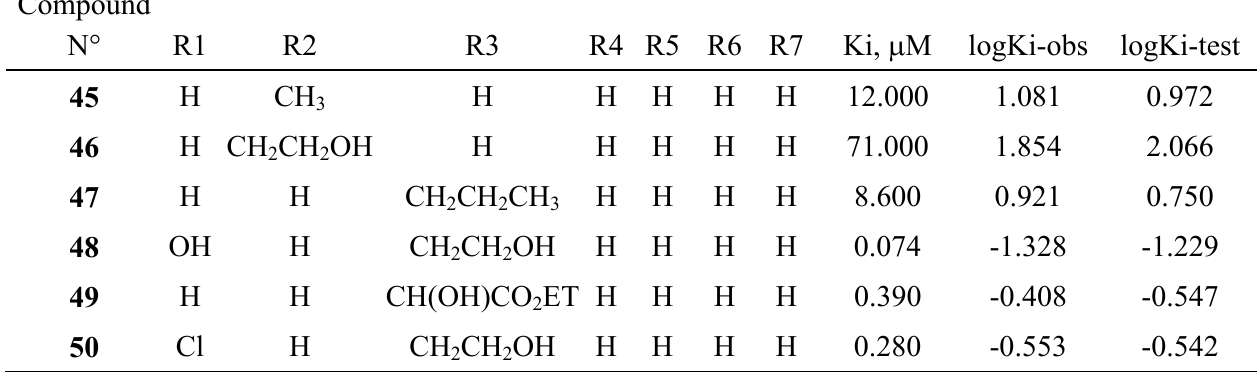
Table 5. The chemical structure of the 6 tested compounds (test set). Values of observed logKi (logKi- obs) corresponding to reference [4] and values of predicted logKi (logKi-test) of the 6 compounds, calculated using